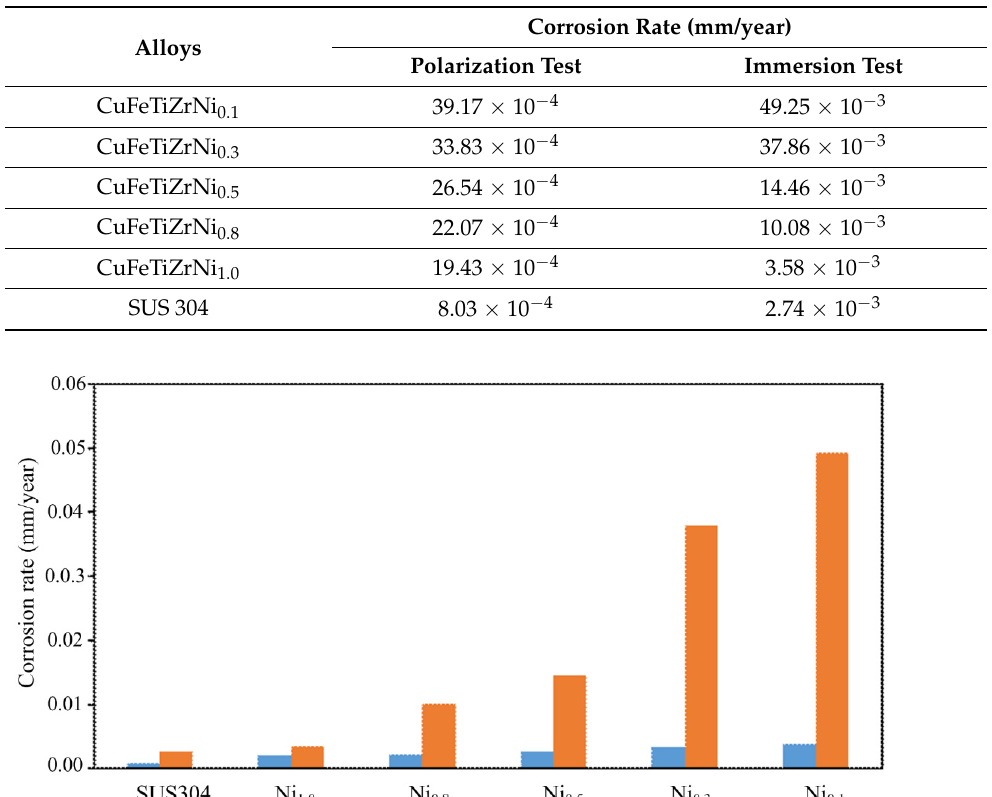
Table 5. The average corrosion rates (mm/year) of CuFeTiZrNi x alloys and SUS 304 in 3.5 wt.% NaCl solution.